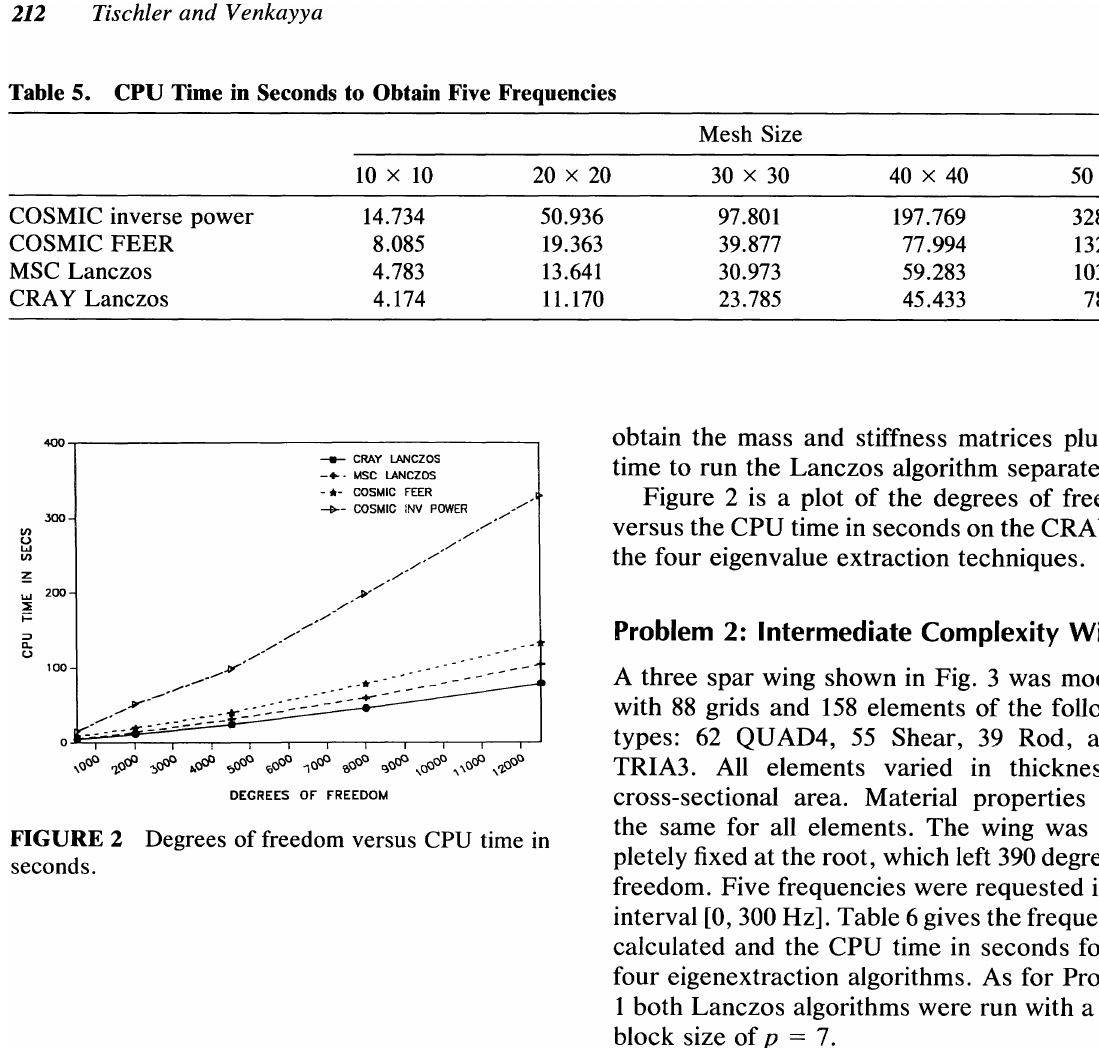
FIGURE 3 Intermediate complexity wing.